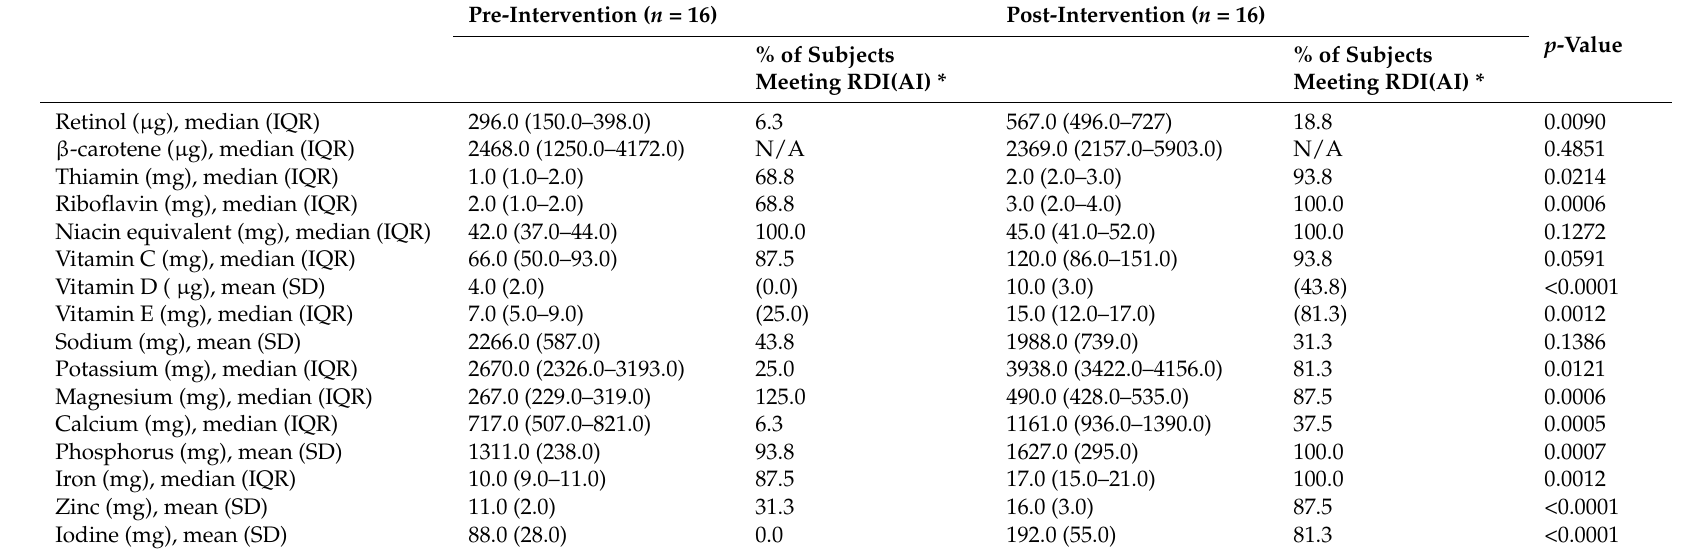
Table 3. Intake of selected micronutrients before and after the weight loss intervention, as determined by self-reported four-day semi-quantitative food diaries. ( n =